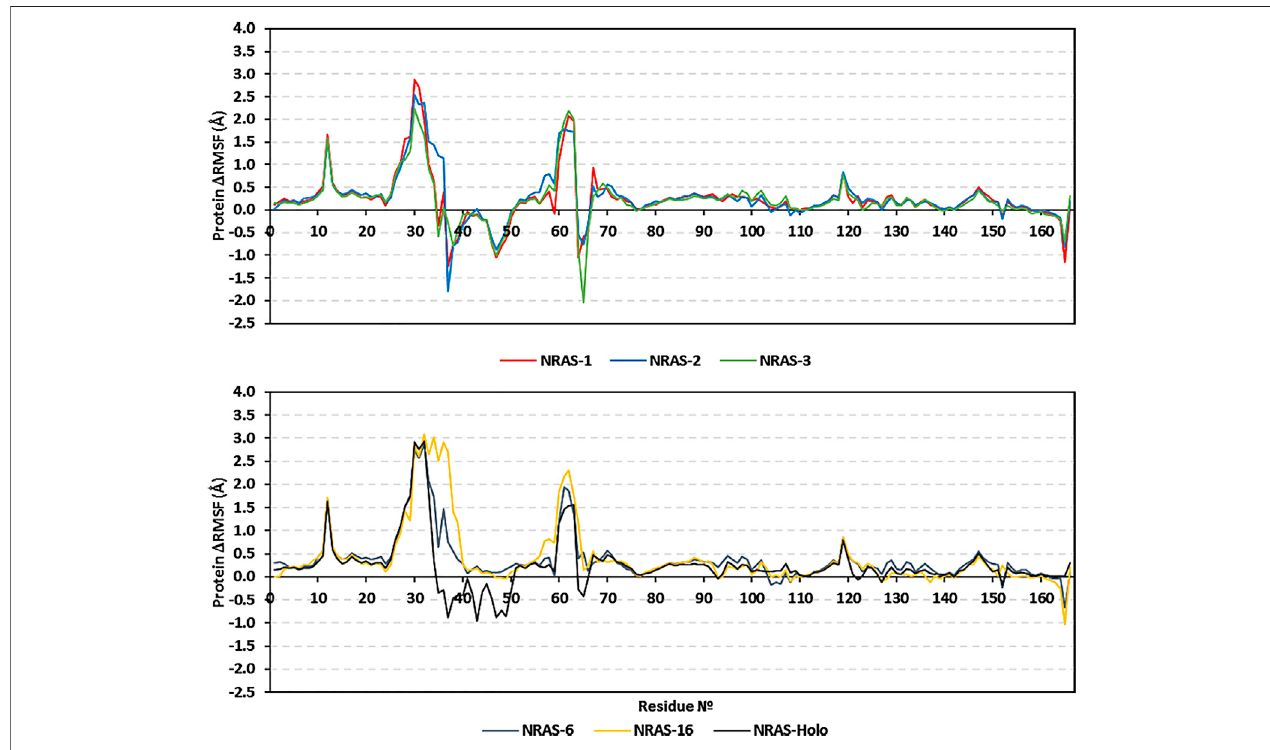
FIGURE 3 | Relative Δ RMSF analysis for the simulated GTP-bounded NRAS proteins along the whole molecular dynamics simulations. The Δ RMSF values, in reference to protein backbone C α -atoms, are represented in terms of constituting residue sequence numbers.